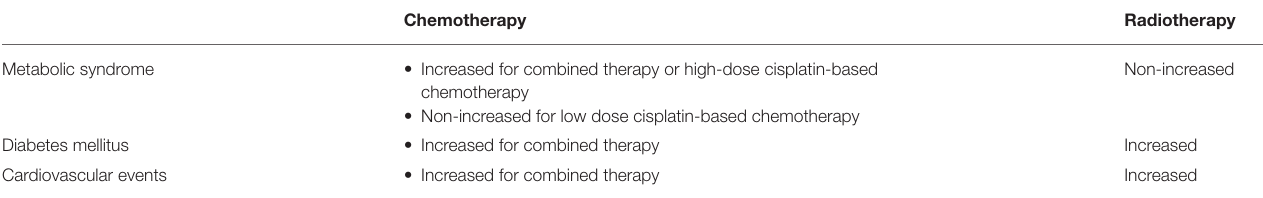
TABLE 6 | Risk for cardiovascular and metabolic complications in testicular tumor survivors.